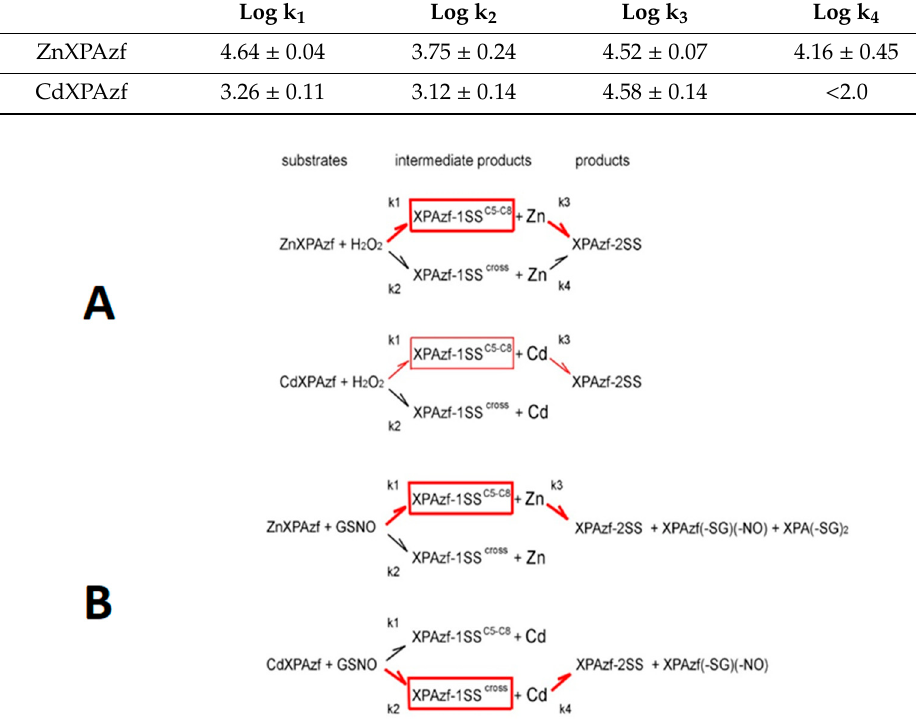
Figure 3. The kinetics of reactions of 10 μ M ZnXPAzf and CdXPAzf with a three-fold excess of H 2 O 2 , plotted from the normalized HPLC peaks. Black—reduced XPAzf (in fact MeXPAzf complex), red— XPAzf-SS C5-C8 , blue—XPAzf-SS cross , orange—XPAzf-2SS. Table 1. Logarithmic values for 2nd order rate constants (M − 2 · h − 1 ) obtained for reactions of ZnXPAzf and CdXPAzf with H 2 O 2 . The k 1 , k 2 , k 3 , and k 4 pathways are defined in Scheme 1. Log k 1 Log k 2 Log k 3 ZnXPAzf